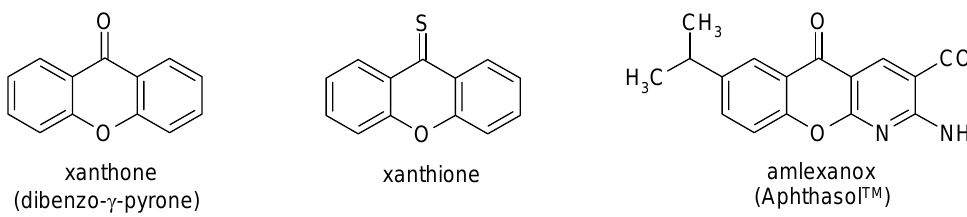
Figure 1. Xanthone, xanthione and its heterocyclic analogue